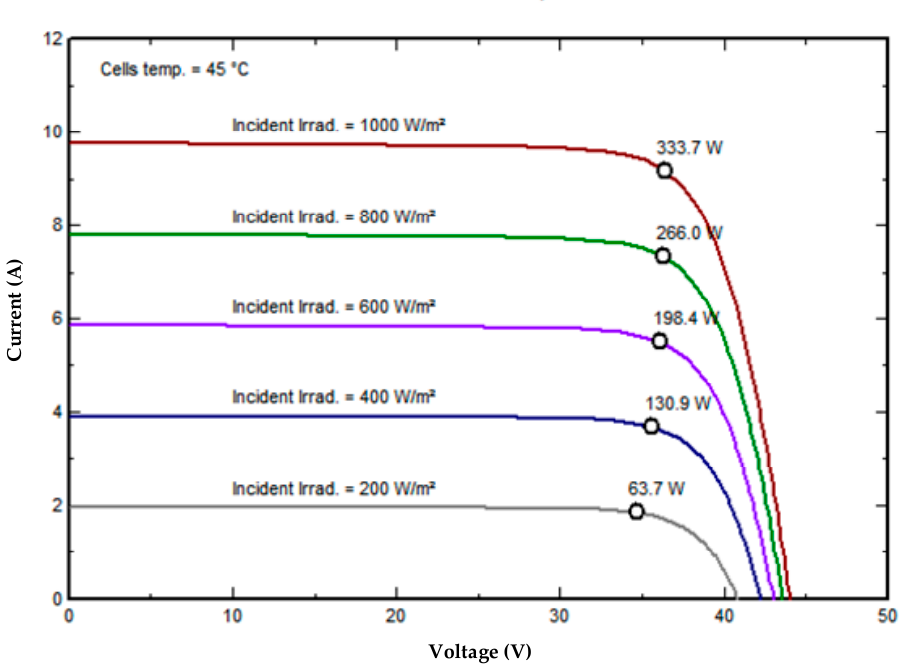
Figure 7. VI characteristics curve for Canadian solar panel CS3U-360P P4.